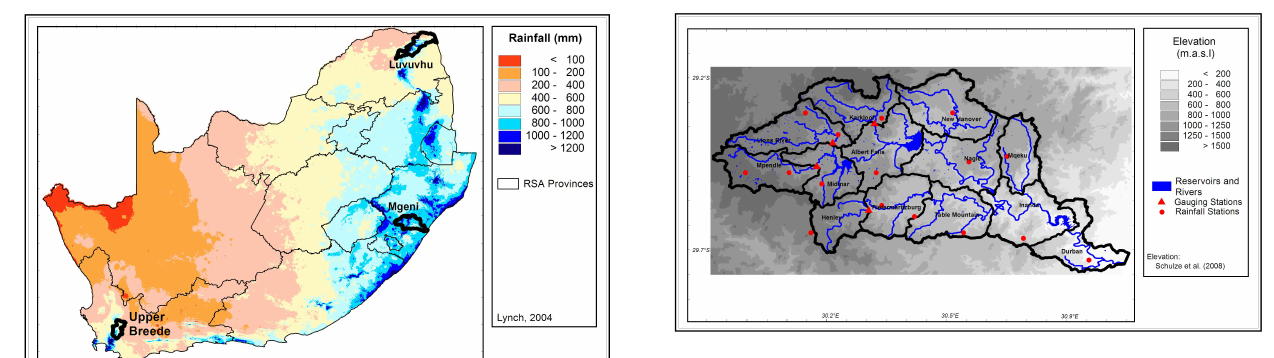
Fig. 3. Water Management Units of the Mgeni